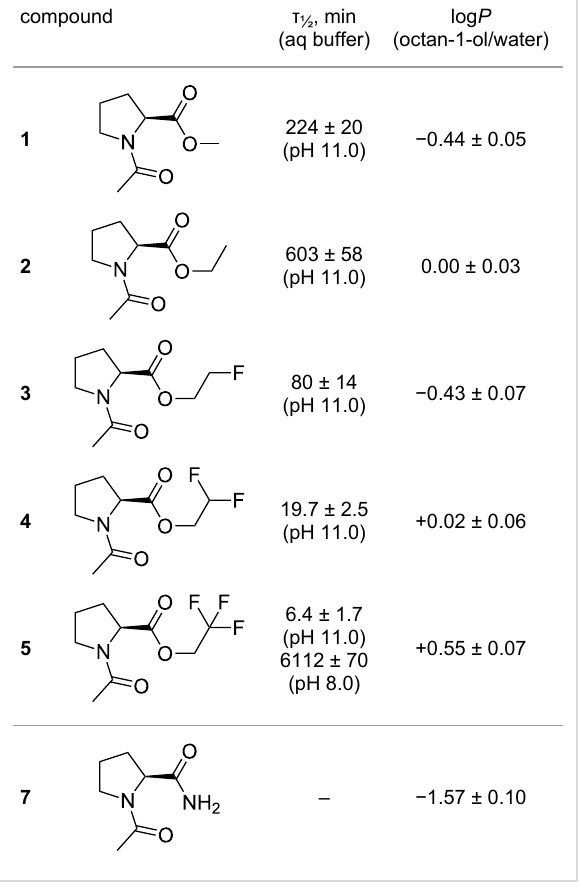
Table 1: Summarized properties of the analyzed compounds as deter- mined by NMR at 298 K.